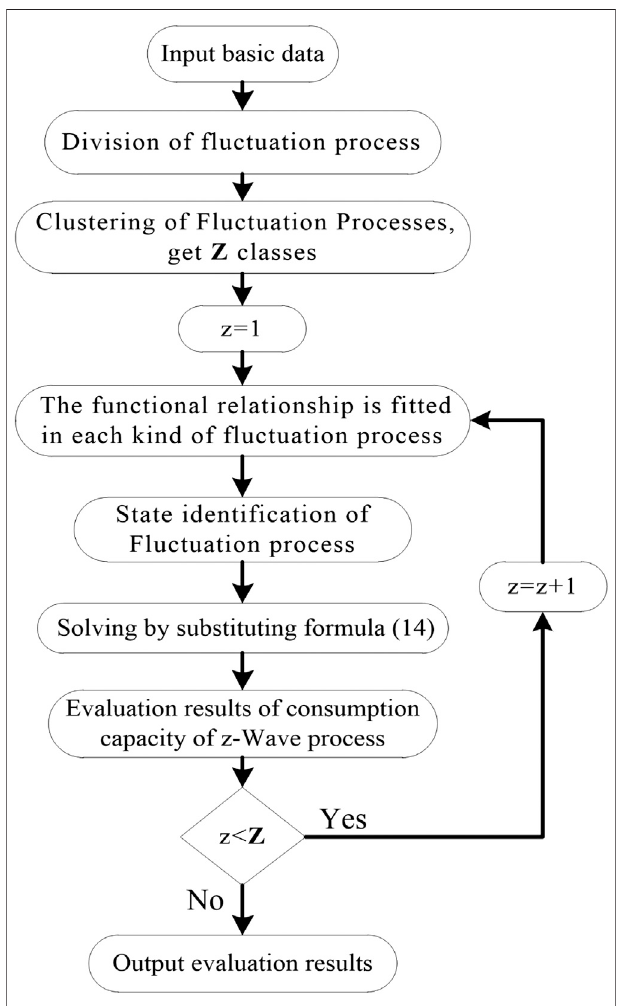
FIGURE 2 | Flow chart of wind power consumption capacity